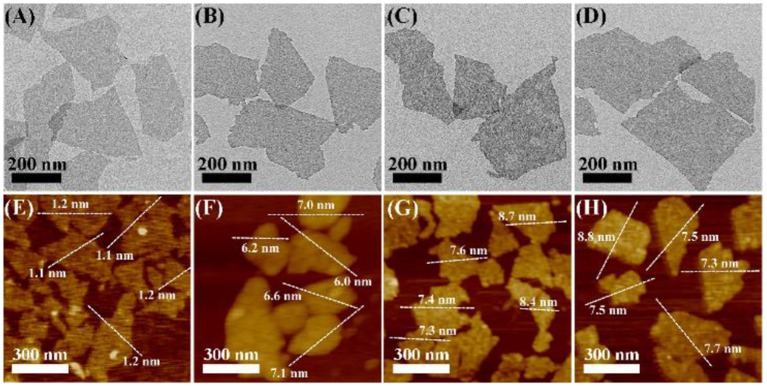
Transmission electron microscopy (TEM) images (A–D) and atomic force microscopy (AFM) images (E–H) of MoS2 NSs, MP NSs (MoS2@PDA NSs), MPP NSs (MoS2@PDA-PEG NSs), and MPPI NSs (MoS2@PDA-PEG/IgG NSs), respectively.